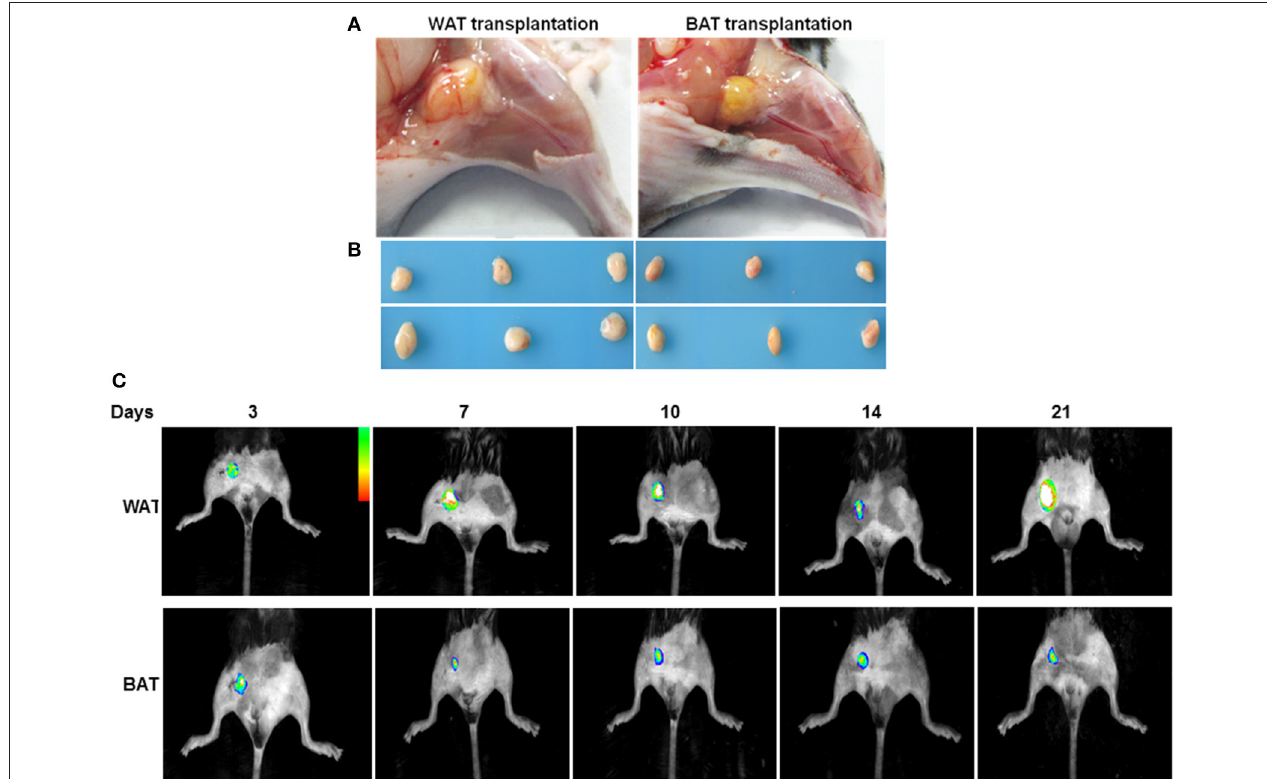
FIGURE 1 | Adipose tissues 21 days after transplantation. (A) The depot (yellow, at center, originally 50mg) subcutaneously transplanted over the adductor muscle region. (B) Adipose tissue depots 21 days after transplantation. Representative images of transplanted AT at the completion of the treatment protocol. (C) Transplanted eGFP pads were imaged by capturing fluorescence signal using an in-vivo Imaging System at indicated time